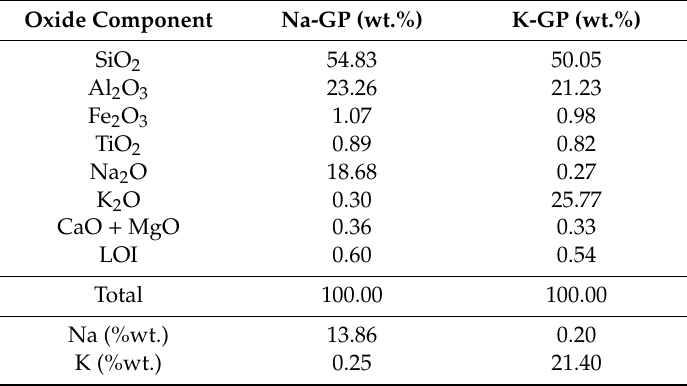
Table 3. Oxide composition on a dry basis of the sodium-based (Na-GP) and potassium-based (K-GP) geopolymers tested in this work. Oxide Component Na-GP